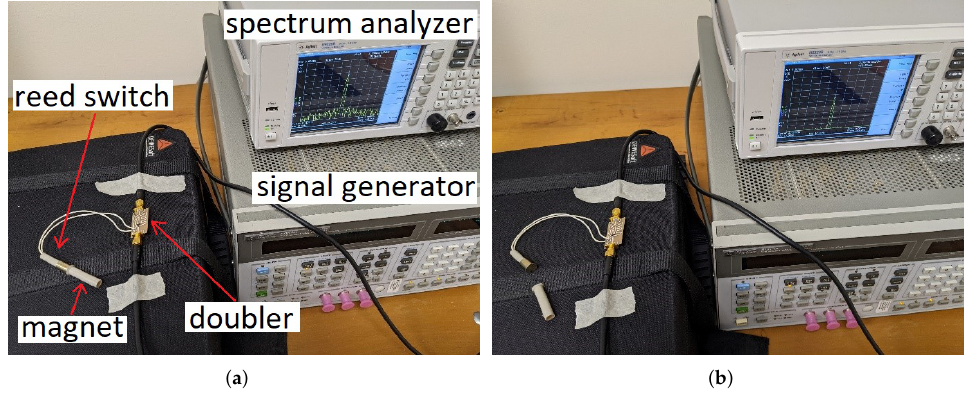
Figure 11. Frequency doubler modulated by means of a reed switch. ( a ) reed switch on. ( b ) reed switch